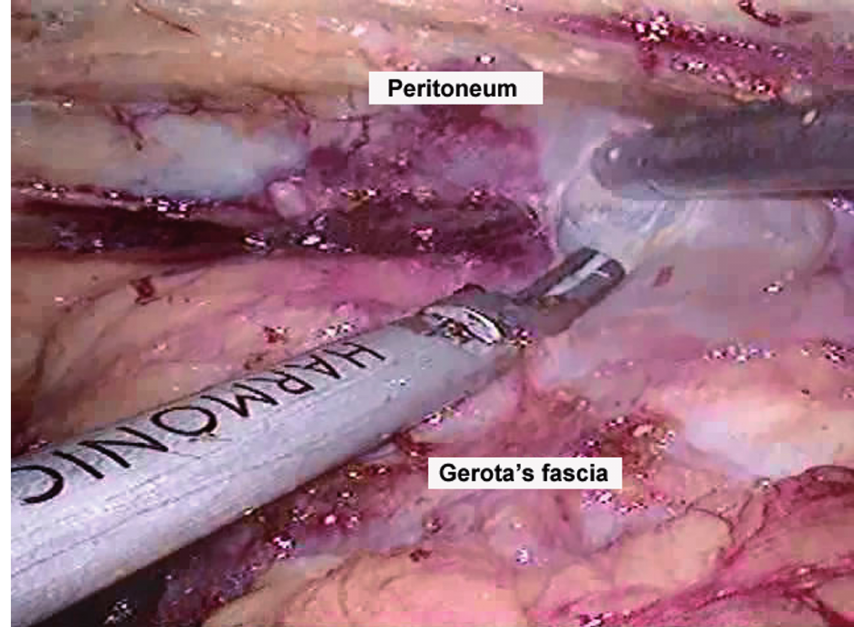
Figure 3 - Dissection of the diseased kidney outside the Gerato’s